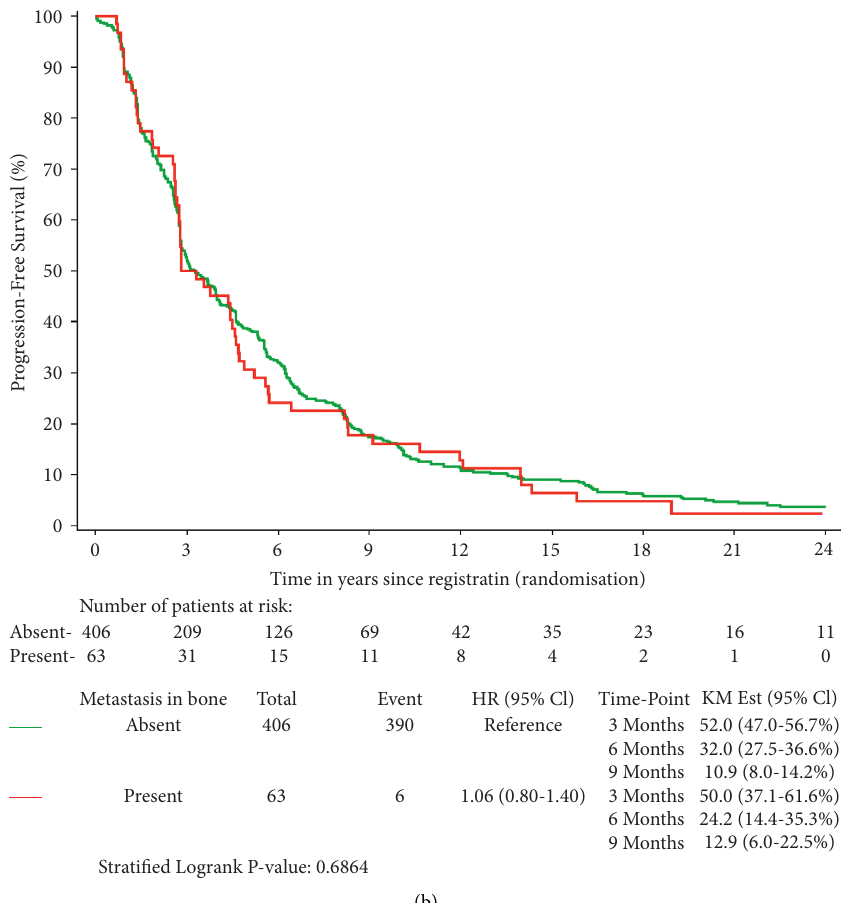
Figure 3: Kaplan–Meier curves for the effect of bone metastasis on PFS stratified by study: (a) first line and (b) second line or higher